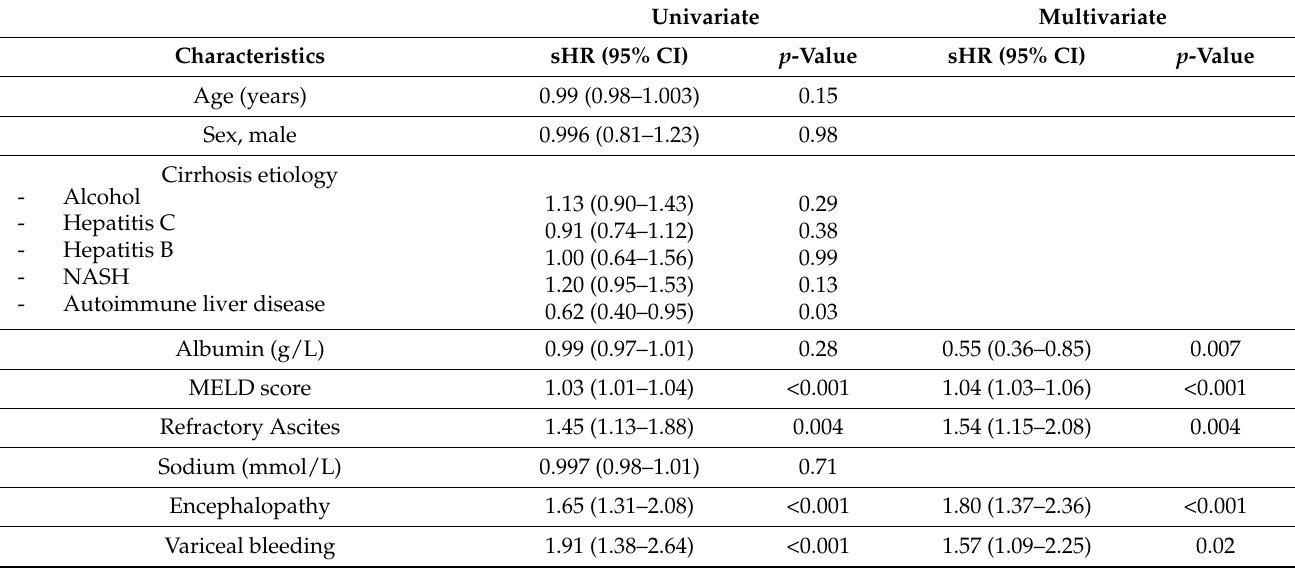
Table 1. Factors associated with mortality in univariate and multivariate competing risk analyses. Univariate